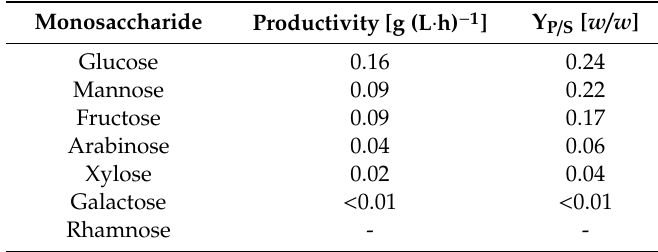
Table 1. Cultivation of U. rabenhorstiana in test tubes with di ff erent monosaccharides as